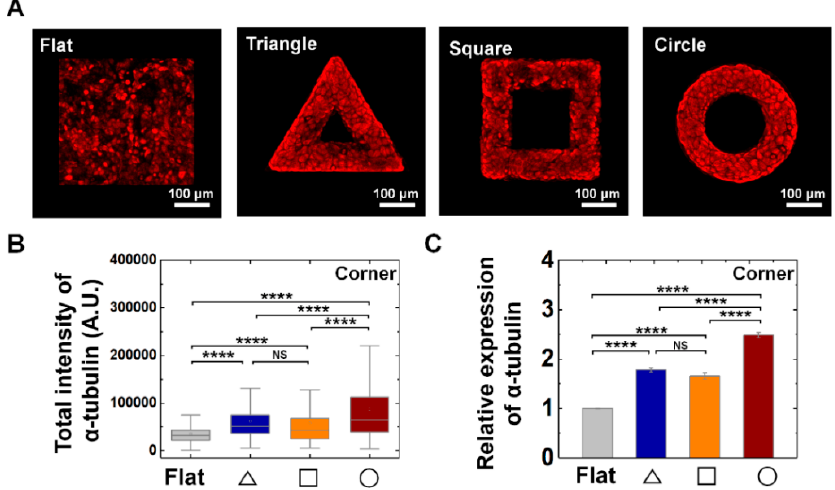
Figure 7. Enhanced α -tubulin expression on convex geometric structure. ( A ) Representative fluorescence images of α -tubulin (red) in MDCK cells on the flat, triangle, square, and circle structure. ( B ) The box plots indicate the total intensity of α -tubulin per individual cells on corner of triangle (navy), square (orange), and circle (red) structure. The result from flat surface is plotted in gray color as a control ( N = 6). ( C ) Mean relative α -tubulin intensity of the cells on the geometric structure compared to that on the flat surface. N cell for flat surface and triangle, square, circle structure was 4893 and 603, 704, 1487, respectively ( N = 6). Error bars in graph indicate S.E.M. One-way ANOVA with post-hoc Fisher’s LSD was used. **** p < 0.0001; NS, non-significant.